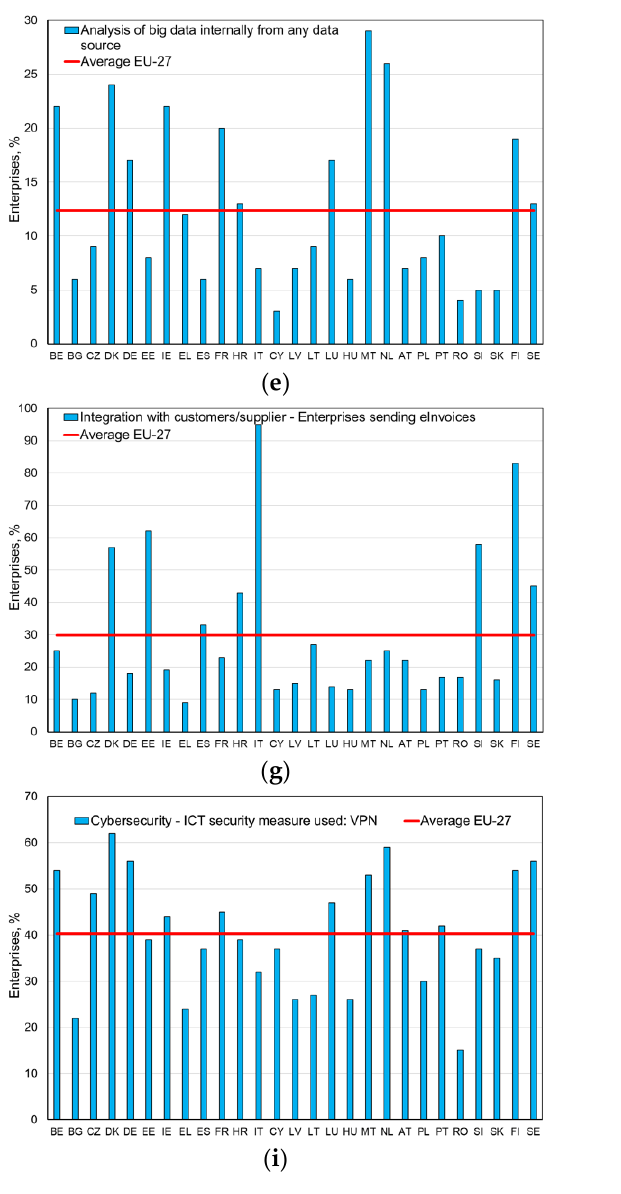
Figure 2. The use of studied digital technologies and infrastructure for Industry 4.0 among the enterprises of individual EU-27 countries (( a ) — Enterprises using AI technologies; ( b ) — Use of interconnected devices or systems that can be monitored or remotely controlled via the internet (Internet of Things); ( c ) — Use of 3D printing; ( d ) — Use of industrial or service robots; ( e ) — Analysis of big data internally from any data source; ( f ) — Purchase of cloud computing services used over the internet; ( g ) — Enterprises sending eInvoices, suitable for automated processing; ( h ) — Enterprises that have ERP software package to share information between different functional areas; ( i ) — ICT security measure used: VPN; and ( j ) — The maximum contracted download speed of the fastest fixed line internet connection is at least 100 Mb/s but less than 500 Mb/s).